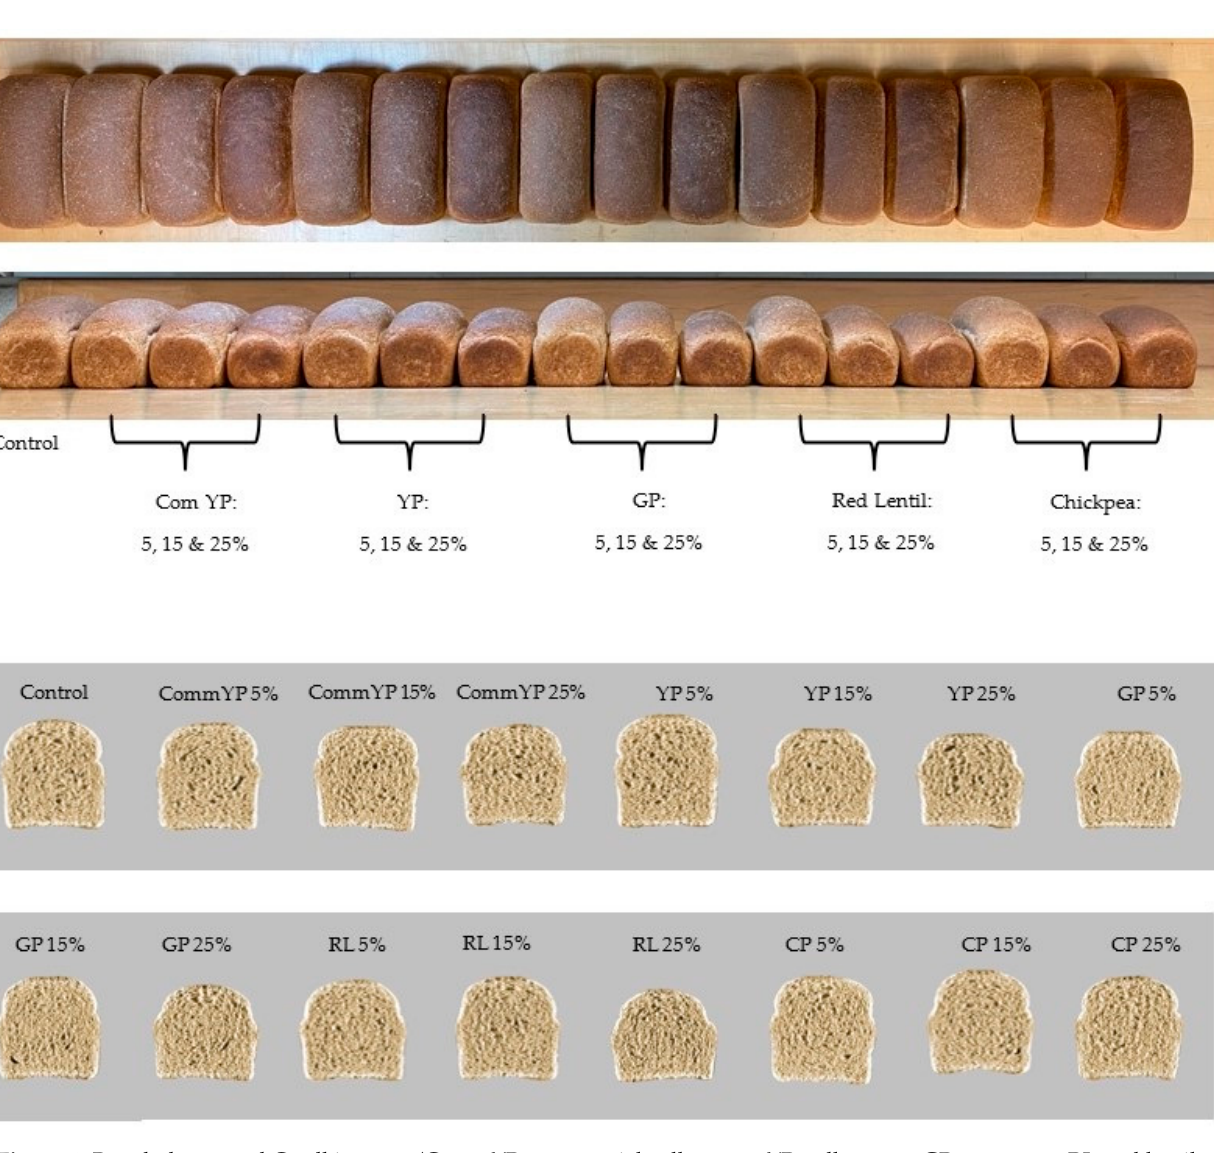
Table 5. Color parameters of whole wheat/pulse bread crumb.